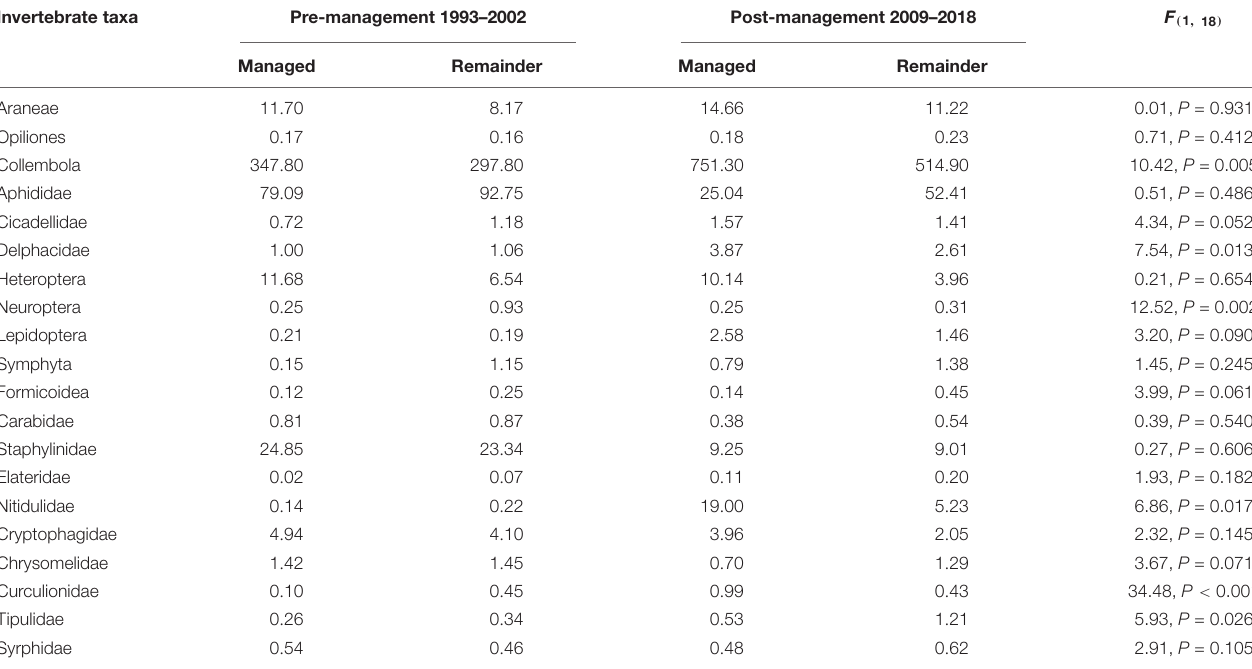
TABLE 2 | Average abundance of invertebrate taxa associated with the diet of farmland birds in the area under gray partridge shoot management (managed) and the conventionally managed area of the Sussex Study (remainder), pre-and post-management. Invertebrate